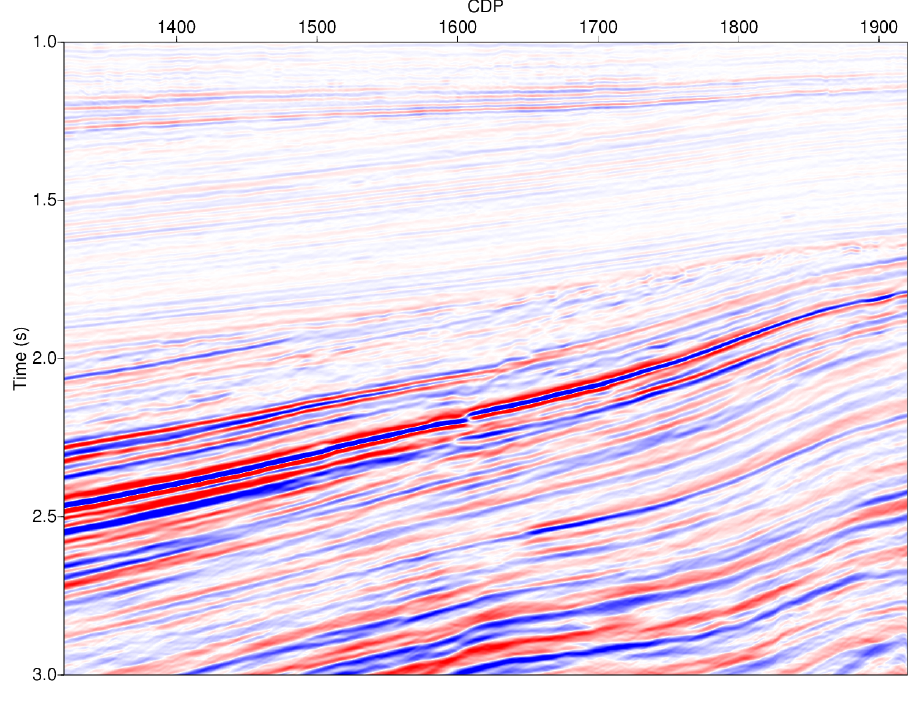
Figure 13. Conventional PSTM image.